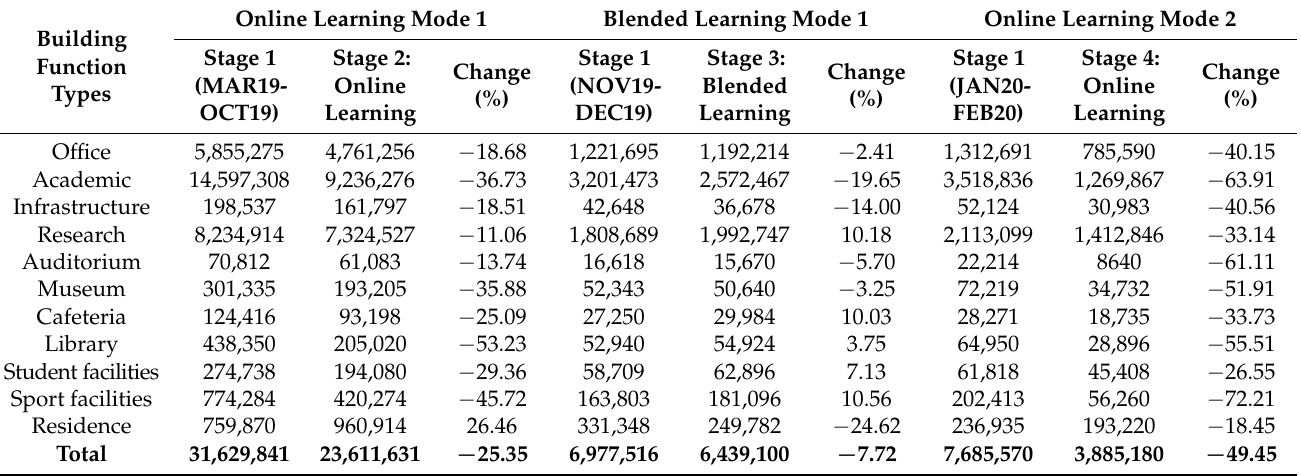
Table 5. Total electricity consumption (kWh) of the building function types in different learning modes as stage of online learning (stage 2: online learning 1 and stage 4: online learning 1) and blended learning (stage 3: blended learning 1), compared with their same period in stage